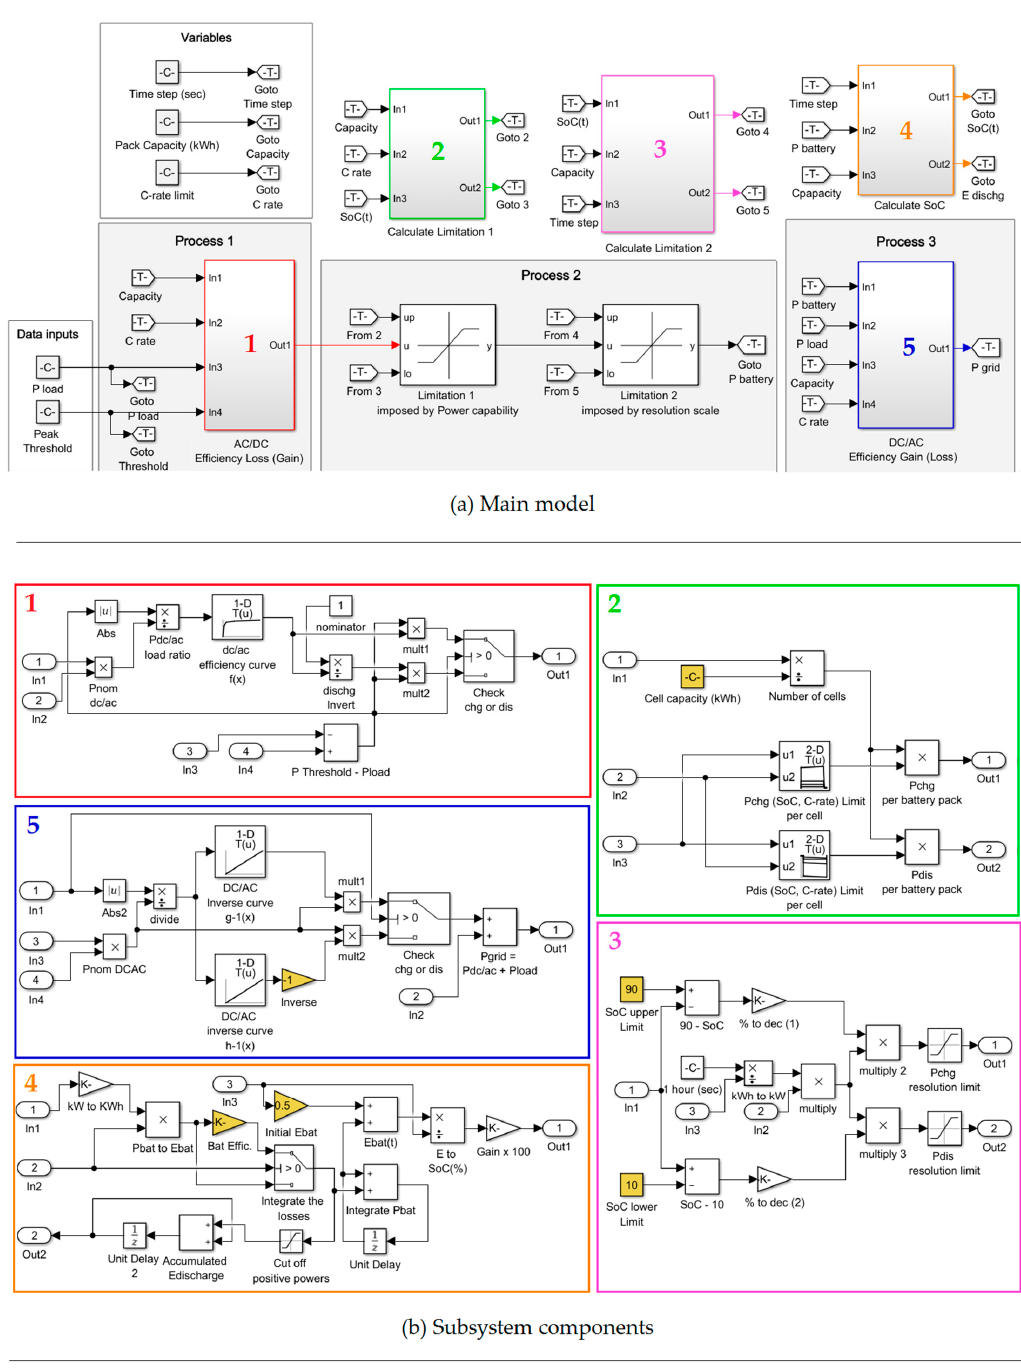
Figure 4 . Power flow model for peak shaving designed in Matlab/Simulink. Figure 4. Power flow model for peak shaving designed in Matlab /